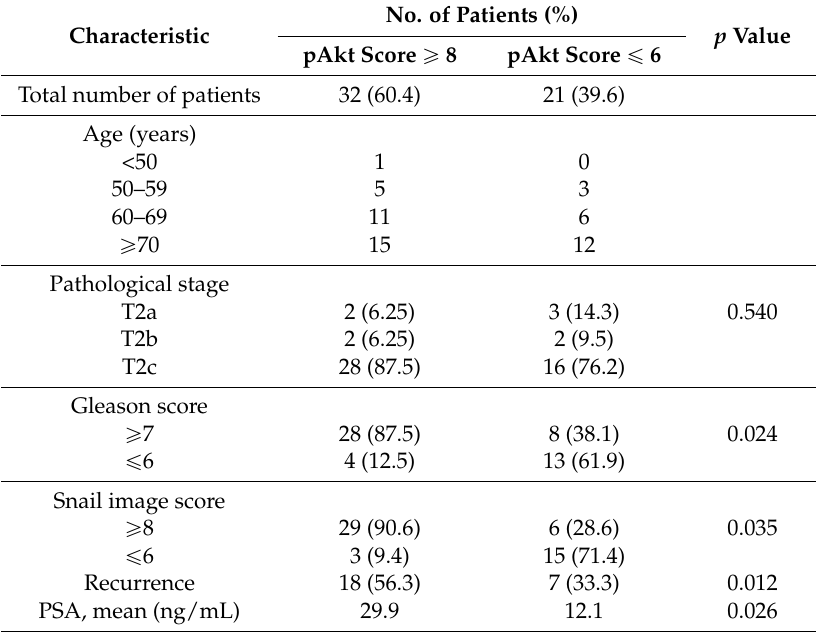
Figure 3. Sensitivity and specificity of gain of a high Gleason score or high p-Akt in specimens with respect to biochemical recurrence (BRC). Areas under the ROC (AUC) for high p-Akt image score ( ≥ 8) and high Gleason score ( ≥ 7) were 0.62 and 0.624, indicating similar discriminatory abilities for BRC.